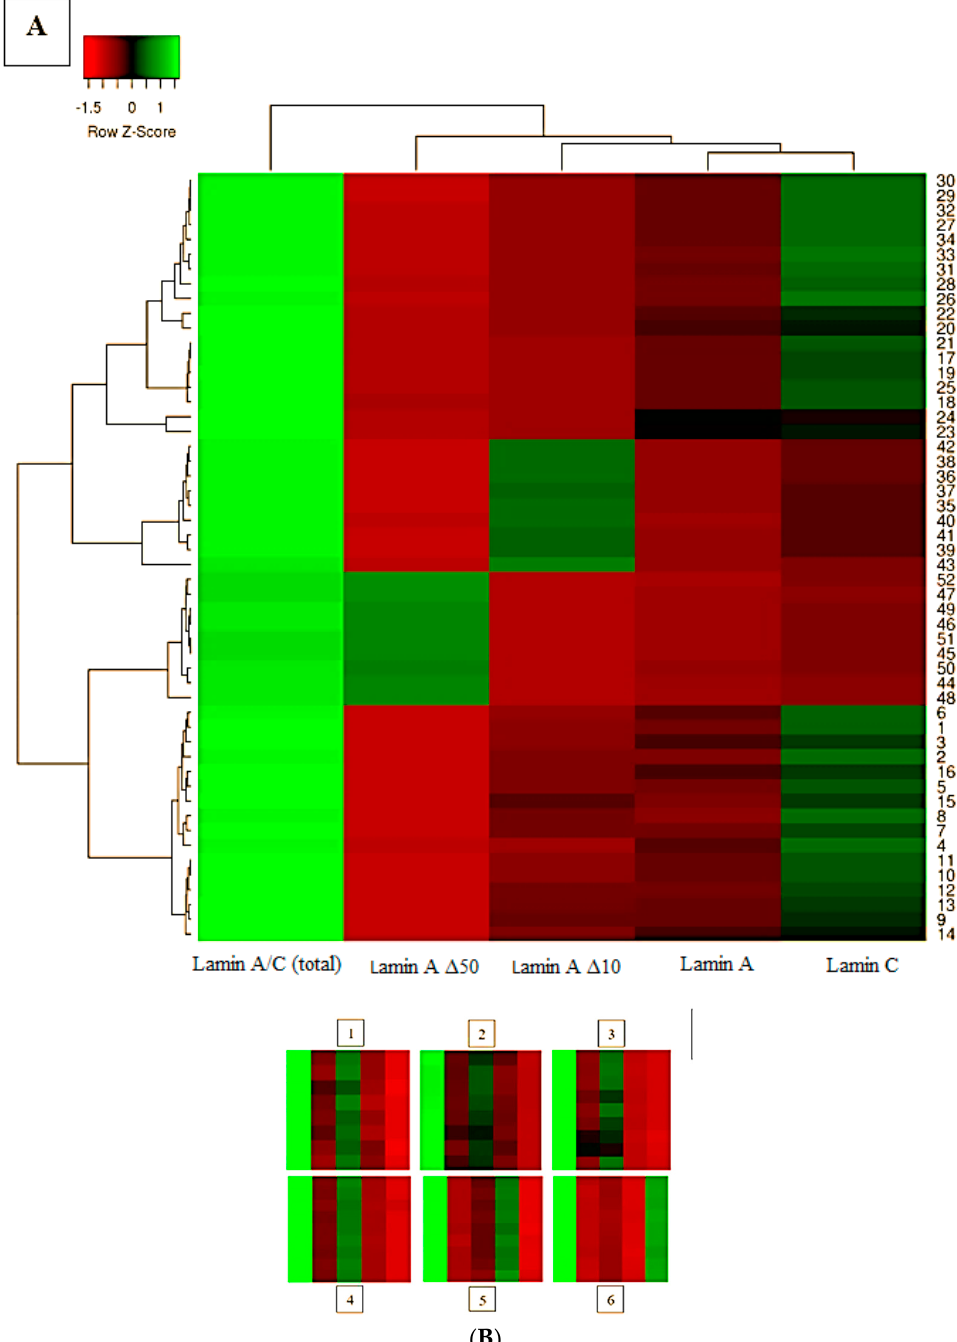
Figure 4. MCF7 cell lines. ( A ) Heat maps showing a two-way comparison of differential expression of lamins in transfected MCF7 cells (where MCF7 exhibits normal lamin expression). PCMV6-XL4 (MCF7 transfected with only PCMV6-XL4 vector with normal lamin expression), lamin A/C (total), lamin C, lamin A Δ 10, and lamin A Δ 50 detected using LC–MS/MS, n = mean of 9 replicates. ( B ) Selected portions of lamin expression levels in MCF7 cells (PCMV6-XL4). Lamin A/C (total), lamin A, lamin C, lamin A Δ 10, and lamin A Δ 50 are indicated by 1, 2, 3, 4, 5, and 6 respectively, which exhibit five concentrations of lamins from light green (high expression level) to red.